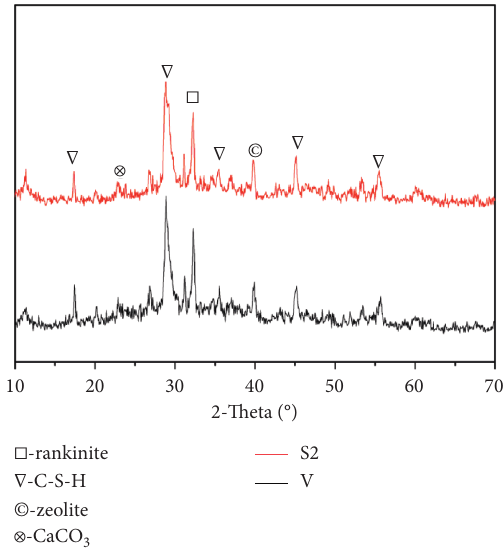
Figure 6: XRD patterns of slag solidified body without adding SiC whisker (V) and with 1% SiC whisker (S2).